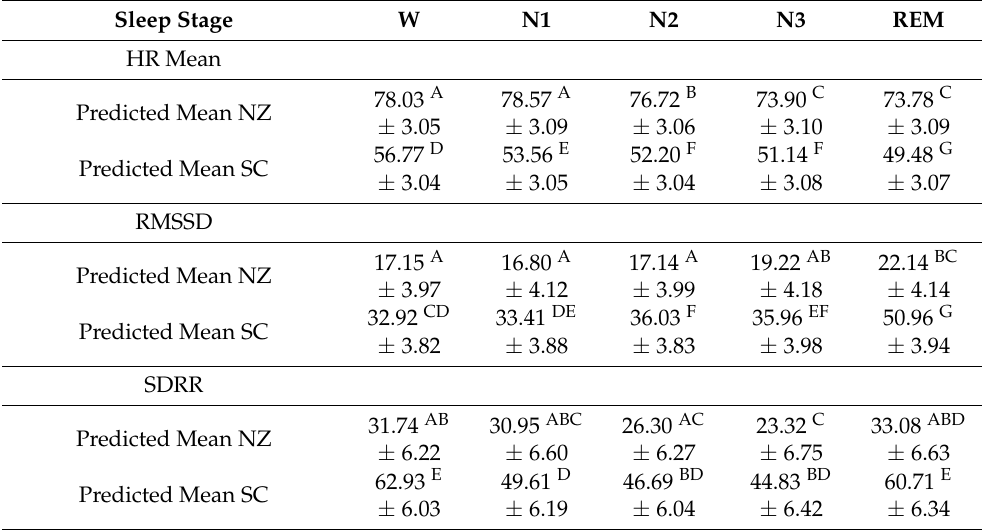
Figure 3. Plots of predicted means with error bars indicating standard error of the mean in each sleep stage for the NZ and Scotland groups for mean HR ( A ), RMSSD ( B ) and SDRR ( C )). Figure produced in R v4.0.5 using ggplot2 package (https://cran.r-project.org/web/packages/ggplot2/index.html, accessed on 3 May 2021). Table 3. Table of predicted means ± standard error of the HR mean, RMSSD and SDRR for each of the stages, awake (W), Non-REM: N1–N3 and REM sleep overall data and by study group in NZ and Scotland (SC).